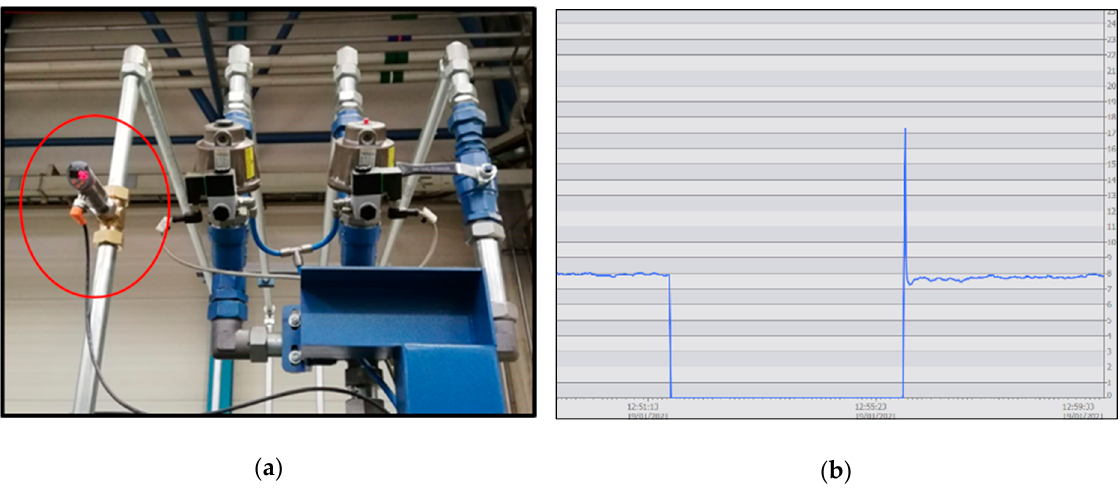
Figure 7. ( a ) Analog flowmeter installed in the machine. ( b ) Coolant flow monitoring.